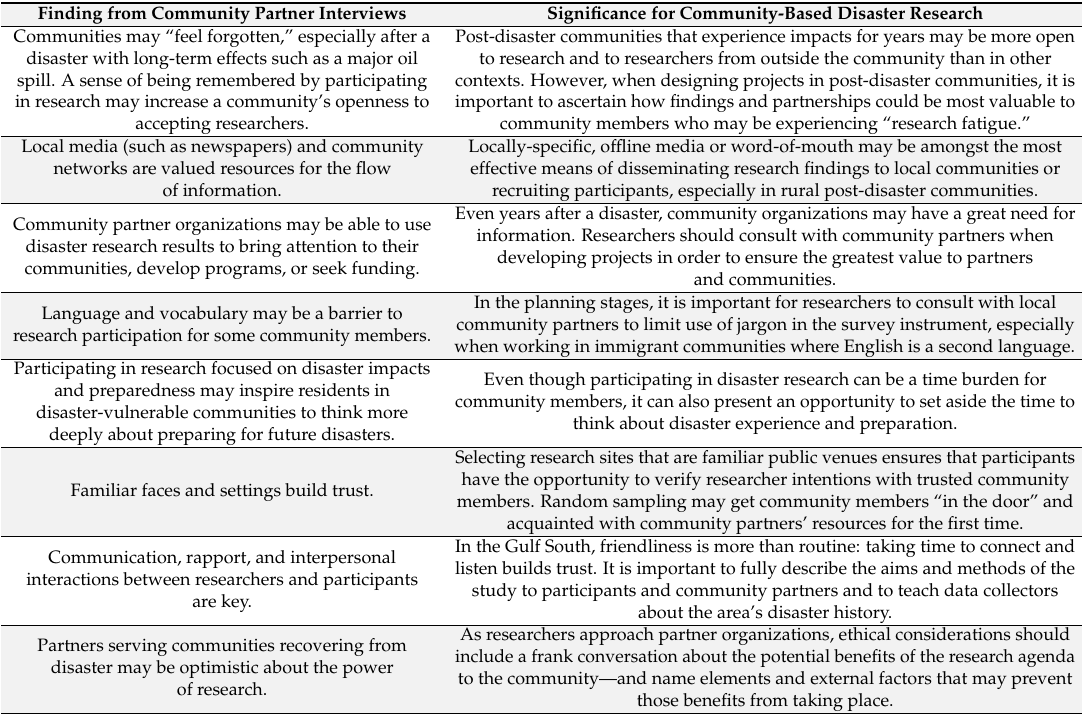
Table 1. Summary of some key findings from interviews with community partners, with significance for broader community-based disaster research